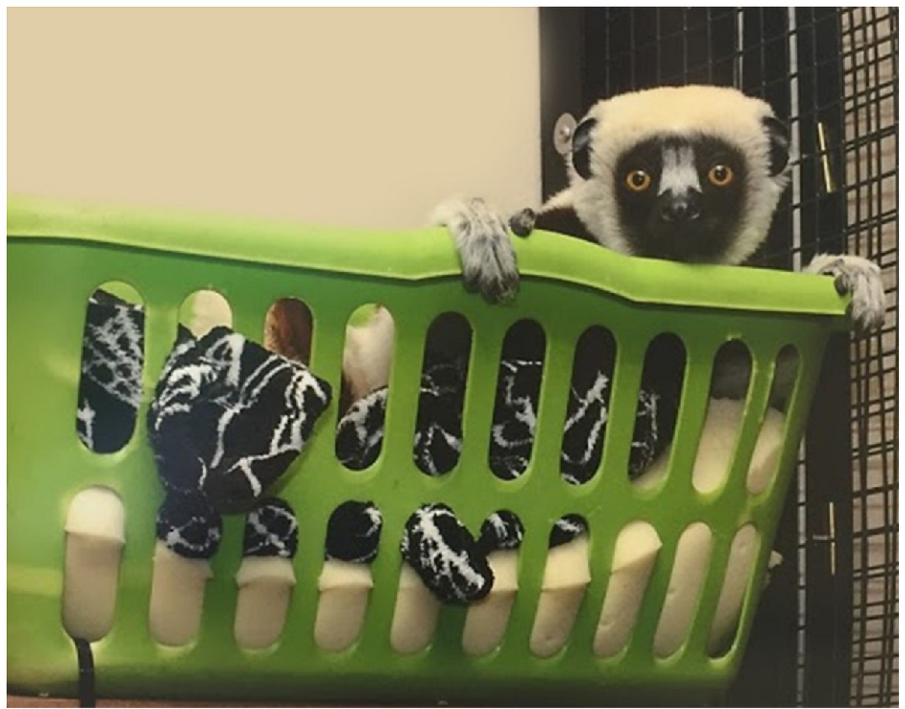
Fig 1. The sleep enrichment experimental condition. A subject Propithecus coquereli perched in the enriched sleep- site provided in the sleep enrichment experimental condition.